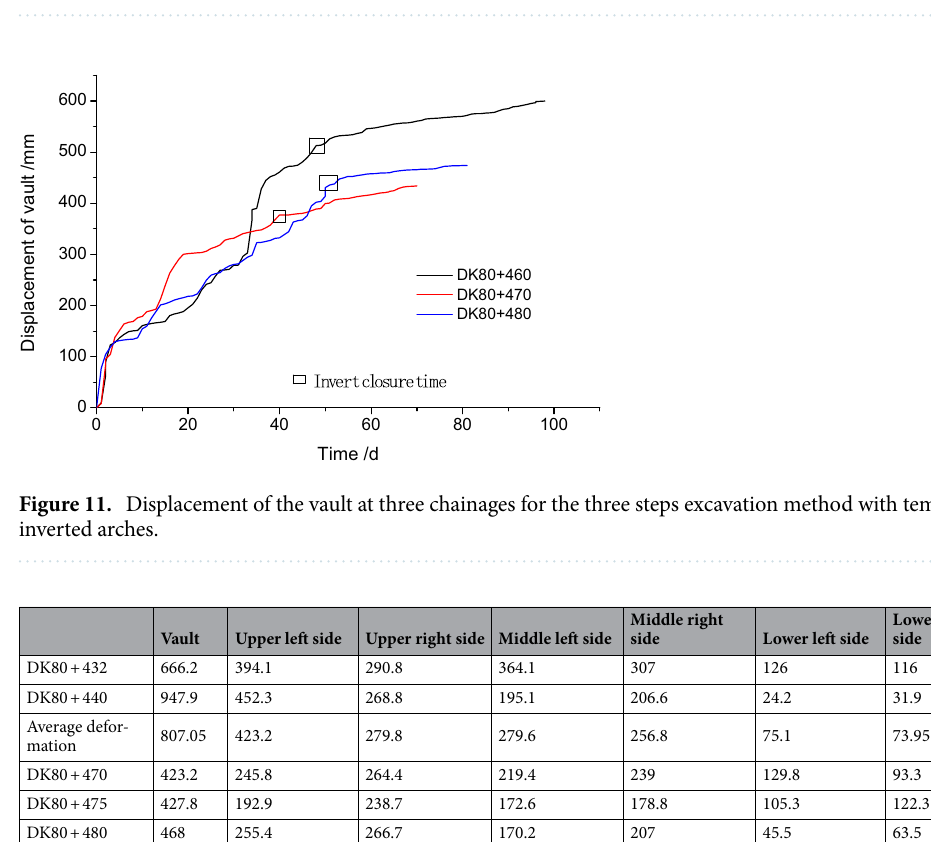
Figure 10. The three steps excavation method with temporary inverted arches.